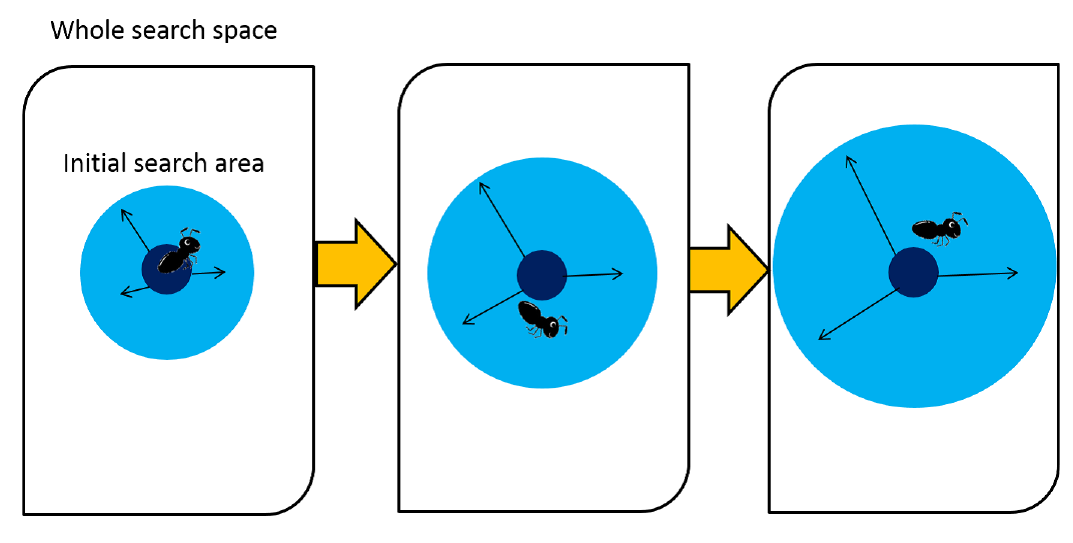
Figure 2. Expansion Technique